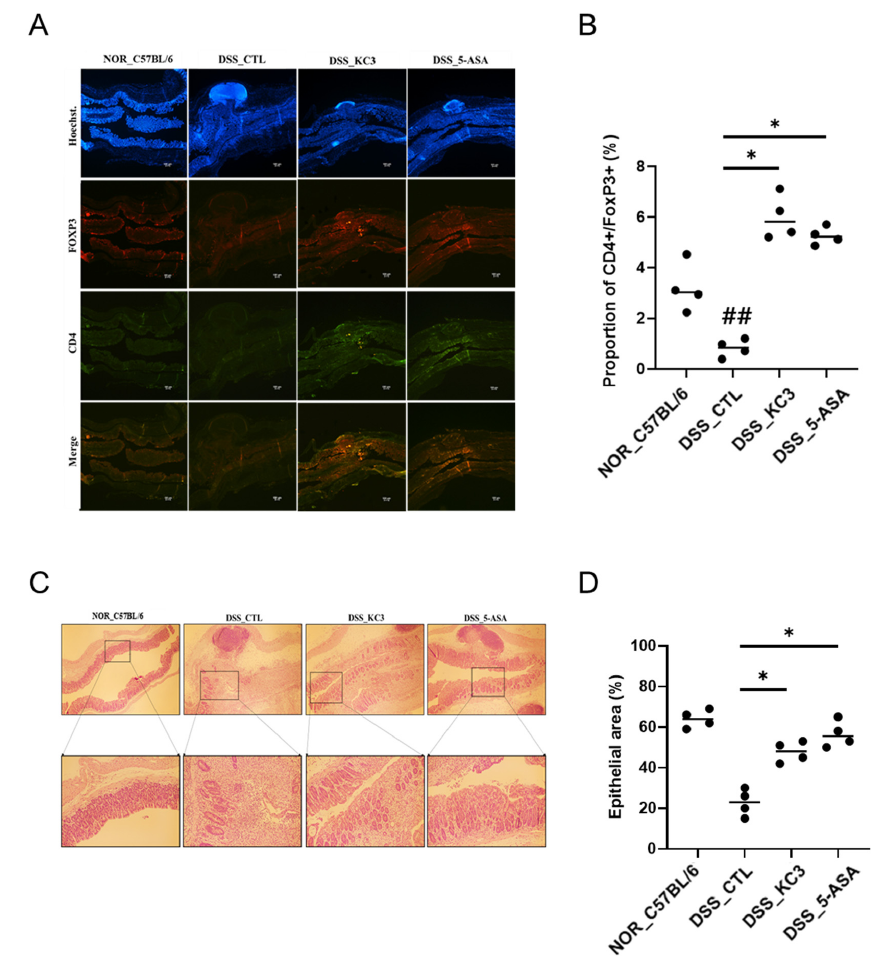
Figure 5. Distribution of T reg cells and inflammatory lesions in colon tissue of mice of DSS-induced colitis. ( A ) Colonic T reg cells were observed at 40 × magnification by confocal microscopy after staining. To stain the nuclei for identifying the background tissue structure using Hoechst (blue), anti-CD4 + (Alexa Fluor 488, green), and anti-FOXP3 + (Alexa Fluor 594, red) merged images is regulatory T cell (CD4 + FOXP3 + ) with yellowish. Scale bar is 100 µ m. ( B ) Proportion of CD4 + FOXP3 + positive area was calculated. ( C ) Histopathological lesion in colon tissue. The normal group showed the intact epithelial structure, whereas the DSS control group showed irregular epithelial lining with inflammatory cells and cell debris. Upper row shows 40 × magnification; lower row shows 100 × magnification. ( D ) The percentage of the area of epithelial cells in the colon tissue was quantified. KC3 treatment improved the epithelial condition by preventing inflammatory cell infiltration. 5-ASA, 5-aminosalicylic acid. * Significant difference compared with the DSS control group ( p < 0.05). ## Significant difference compared with the normal group ( p < 0.01). Data are represented as mean ± SD ( n = 5 per